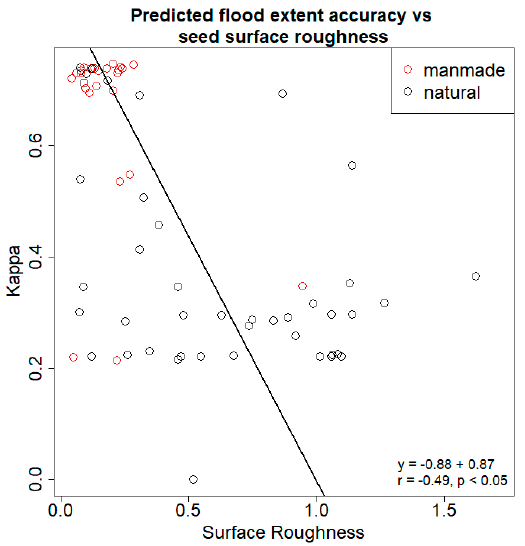
Figure 13. The relationship between the surface roughness surrounding single point-based flood perimeter observations and accuracy of flood extents derived from flood-filling the Lidar DEM.